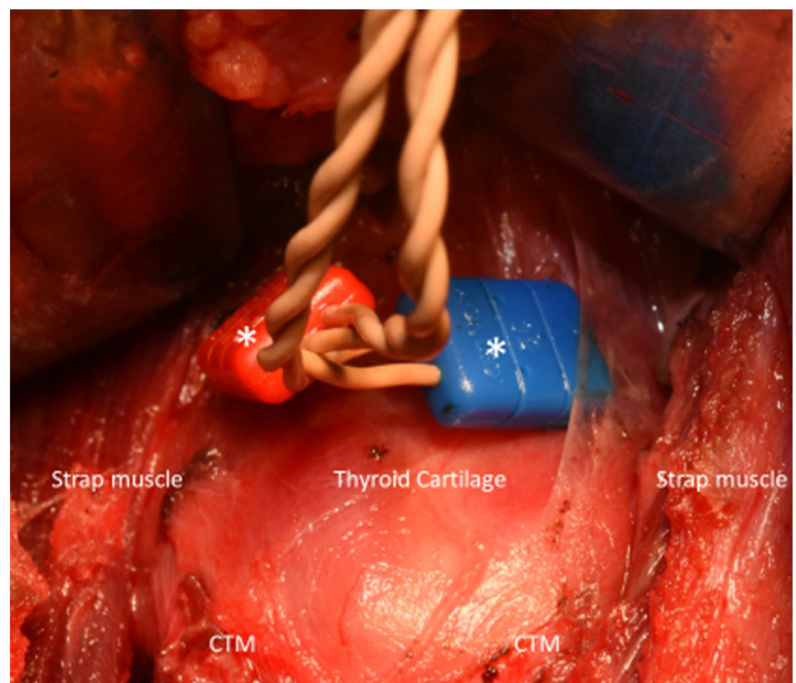
Figure 1. Transcartilage intraoperative neuromonitoring (TC-IONM) performed in a 17-year-old female who had received total thyroidectomy and bilateral central neck dissection of a papillary thyroid carcinoma. Paired 12 mm standard needle electrodes (white asterisk, Medtronic Xomed, Jacksonville, FL, USA) were inserted obliquely into each side of the perichondrium of thyroid cartilage. CTM= cricothyroid